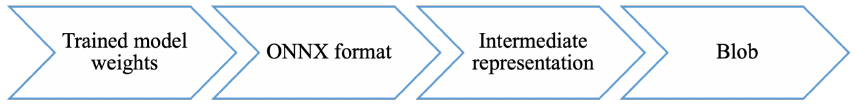
Figure 6. The visual overview of workflow for model conversion to blob